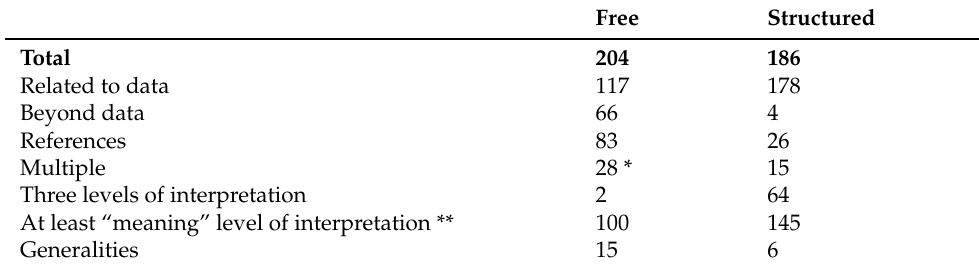
Table 2. Analysis of the annotations produced by premDAT, with the differences between free and structured annotations. * Annotations “beyond data” were not considered for the “multiple observations” dimension, as they usually take the shape of a large explanatory paragraph that can hardly be split into separate “observations.” ** Annotations “beyond data” were considered as “meaning,” as they provide further meaning to the